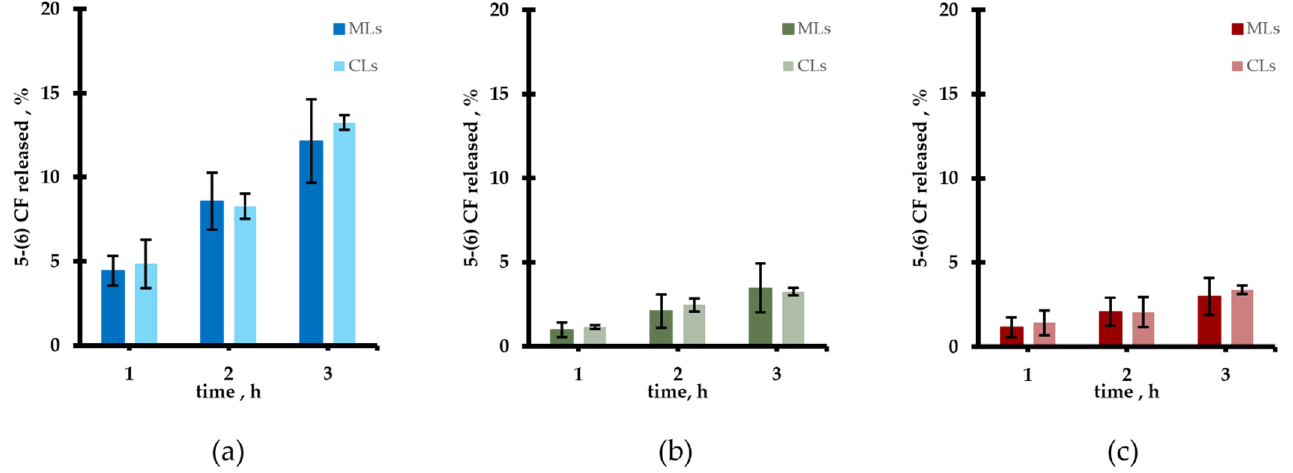
Figure 4. Percentage of spontaneous release from MLs and CLs of: ( a ) Liquid Disorder Liposomes, ( b ) Gel Liposomes, ( c ) Liquid Order Liposomes.